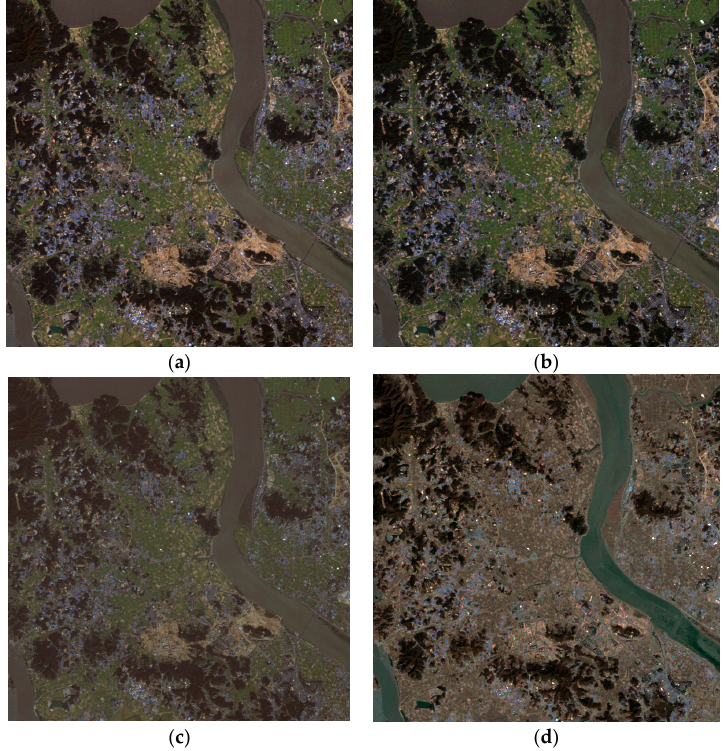
Remote Sens. 2017 , 9 , x FOR PEER REVIEW Figure 7. Normalized subject image: ( a ) MS regression; ( b ) SR; ( c ) NC regression; and ( d ) RF regression.